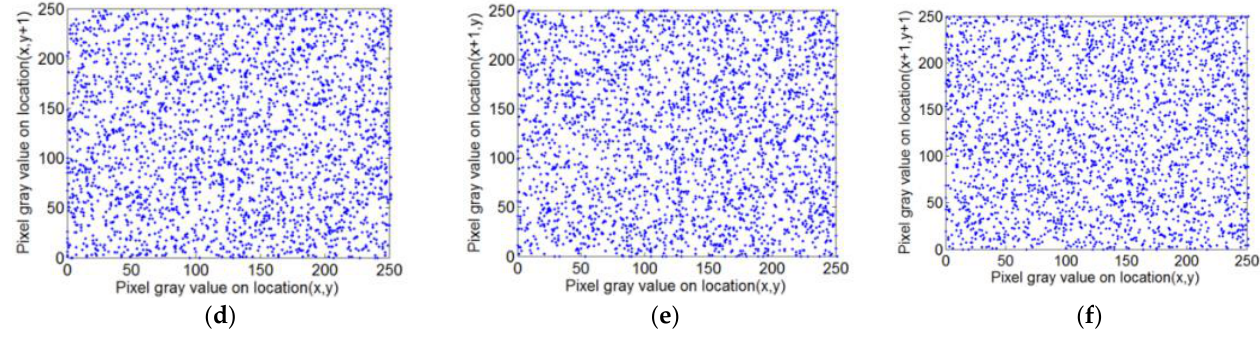
Figure 9. Correlation coefficients of Lena. ( a ) Horizontal correlation of plain image; ( b ) vertical correlation of plain image; ( c ) diagonal correlation of plain image; ( d ) horizontal correlation of the magnitude of ciphered image; ( e ) vertical correlation of the magnitude of ciphered image; ( f ) diagonal correlation of the magnitude of ciphered image. Table 5. Correlation coefficients of Lena.